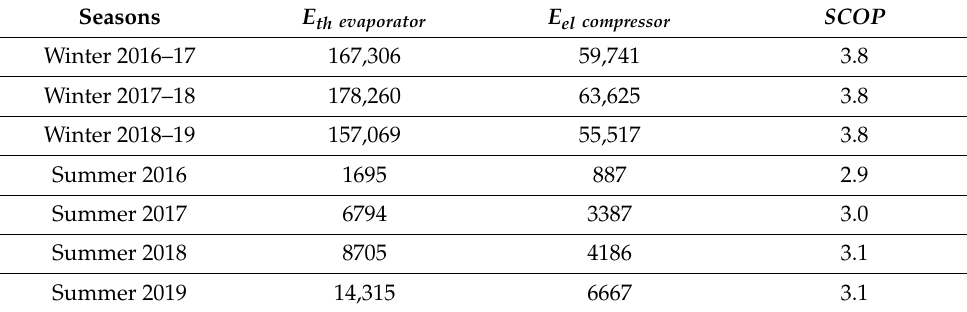
Table 4. Results of the calculation of the SCOP (source: